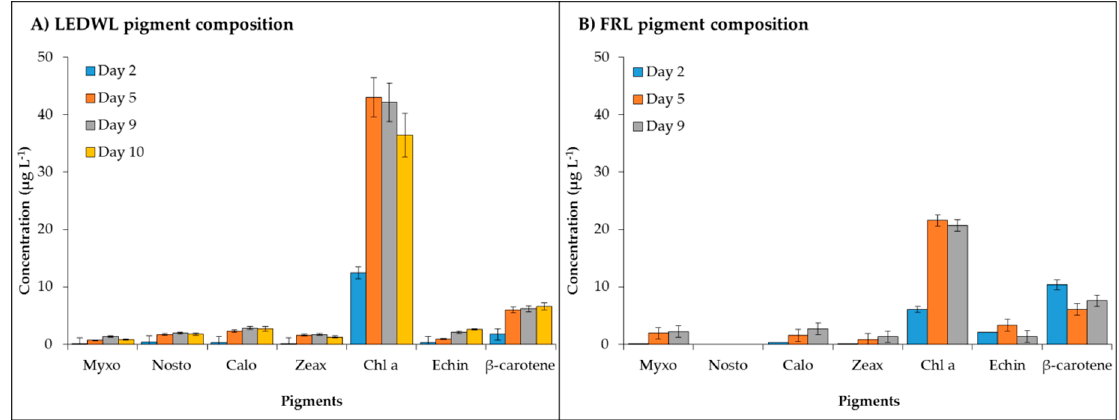
Figure 2. Pigment composition of C. fritschii under ( A ) LED white light (LEDWL) and ( B ) far red light (FRL).